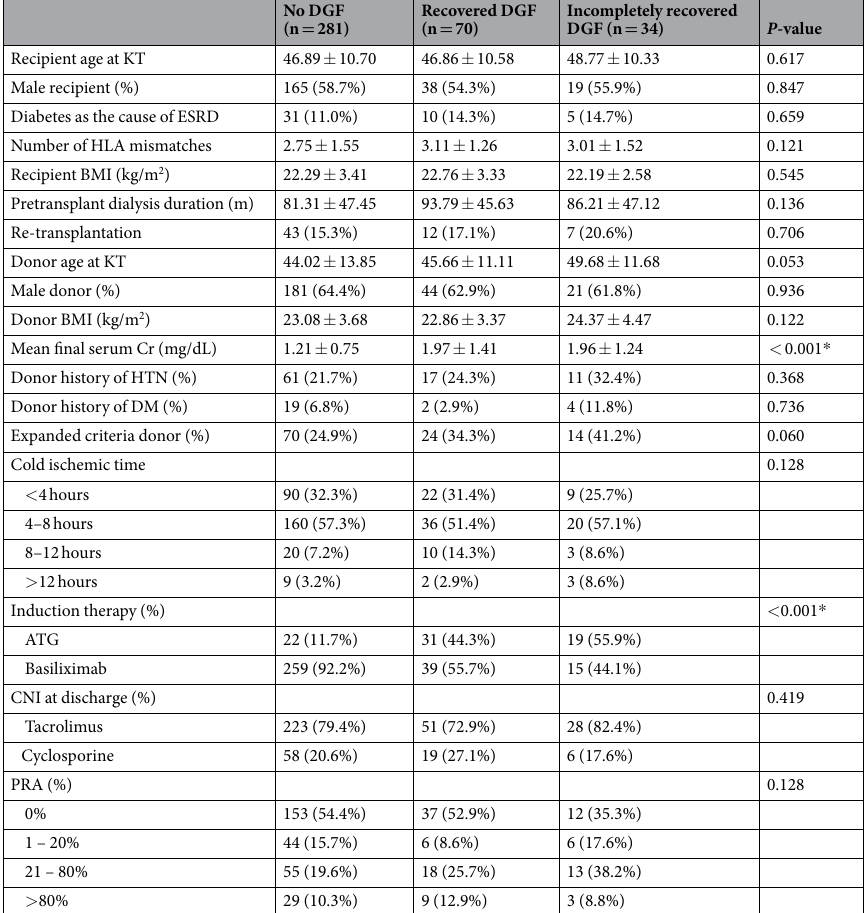
Table 1. Baseline characteristics by DGF recovery status. DGF = delayed graft function, KT = kidney transplantation, DM = diabetes mellitus, ESRD = end stage renal disease, HLA = human leukocyte antigen, BMI = body mass index, Cr = creatinine, HTN = hypertension, ATG = anti-thymocyte globulin, CNI = calcinurin inhibitor, PRA = panel reactive antibodies. * Post hoc Bonferroni: P < 0.05 in all comparisons except recovered DGF vs. incompletely recovered DGF.